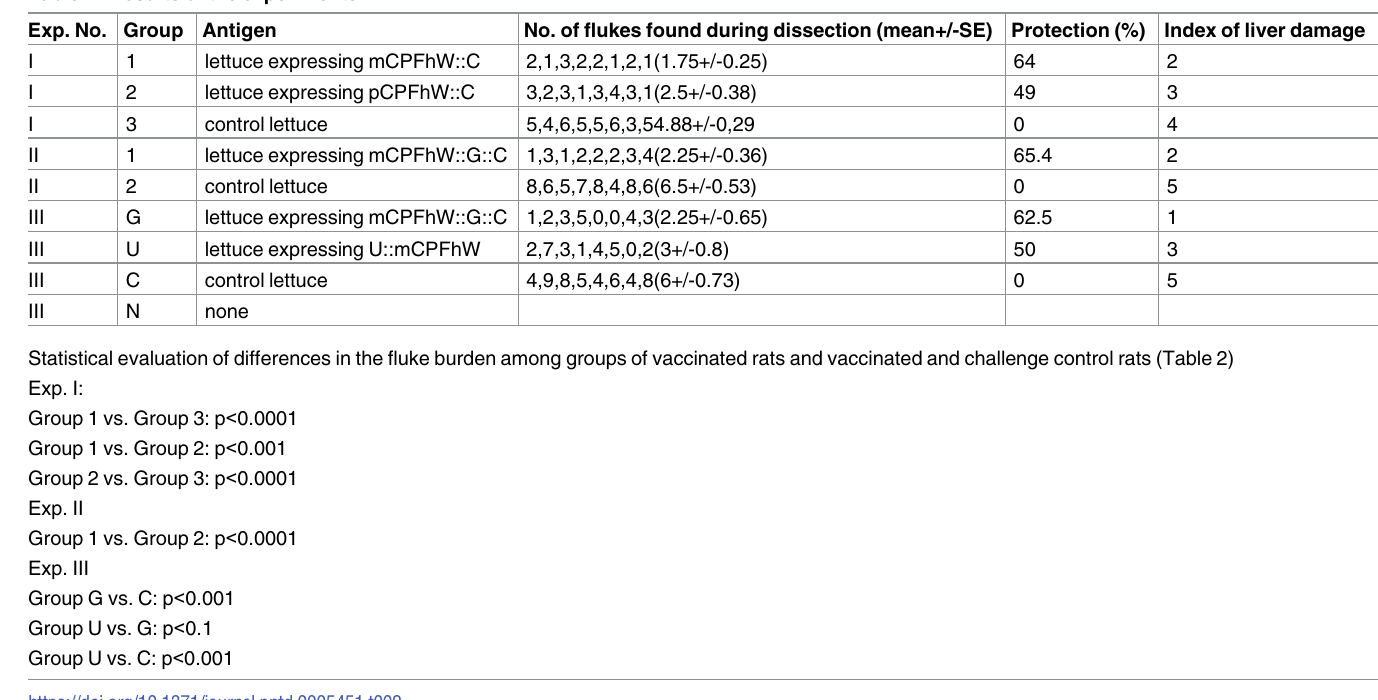
Table 2. Results of the